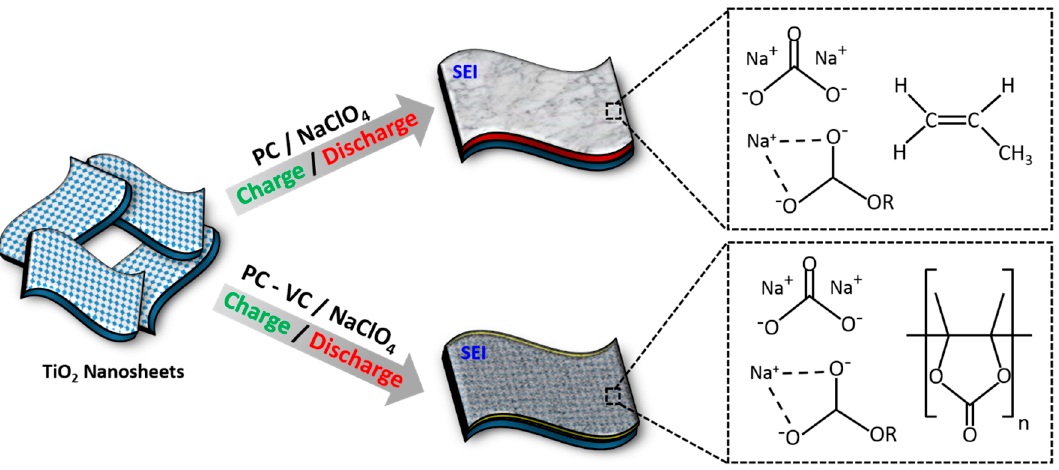
Figure 1. Schematic of the different solid electrolyte interface (SEI) composition on TiO 2 nanosheet anodes formed in vinylene carbonate (VC)-containing and VC-free electrolyte solutions.